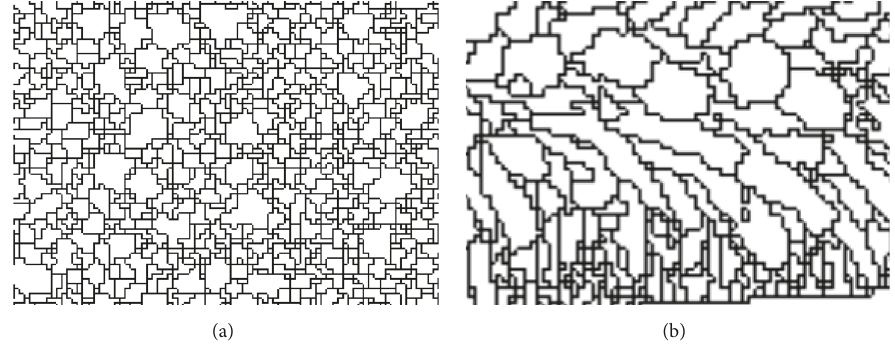
Figure 3: Solidification simulation of twin-roll cast Al-10Mg alloy wedge-shaped plate: (a) rolled plane; (b) longitudinal section.